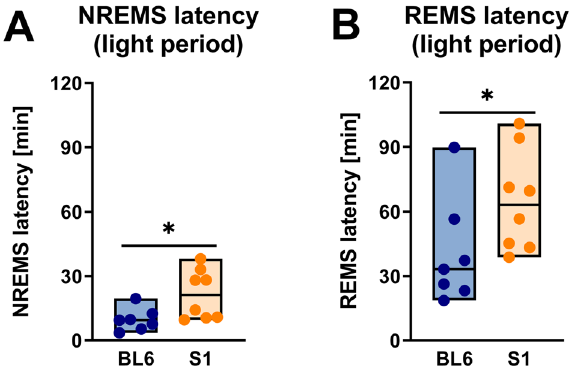
Figure 4. Sleep latencies at the onset of the light period in S1 (n = 8) and BL6 mice (n = 7). The latency to NREMS at the beginning of the light period was higher in S1 than BL6 mice [( A ) p = 0.021]. Accordingly, also the time to enter REMS was increased in S1 mice [( B ) p = 0.029]. All floating bars show min-to-max values with median and individual data points. Statistical significance was determined with a Mann–Whitney U test (*p <